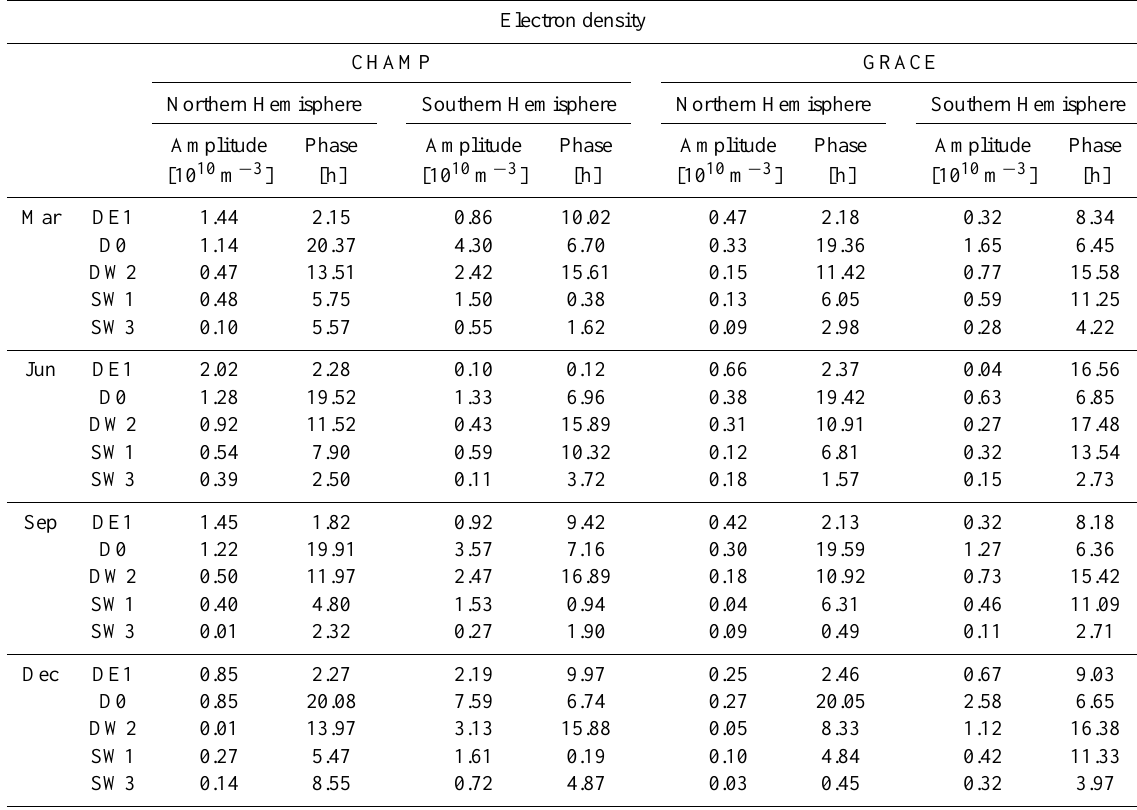
Table 3. Same as Table 1, but for the electron density measurements during the years 2007–2009. The prominent diurnal tide DE1 has also been listed here.